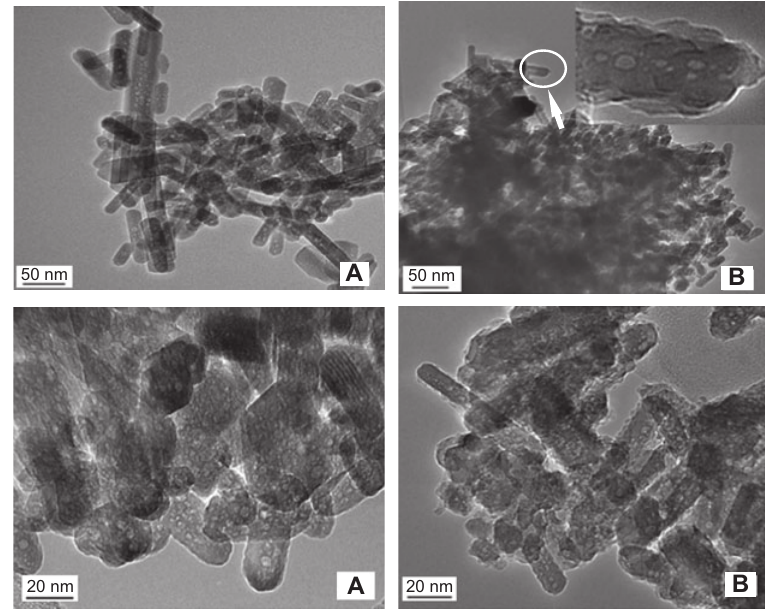
Figure 2 TEM micrograph of (A) HAP particles and (B) silica-coated HAP.